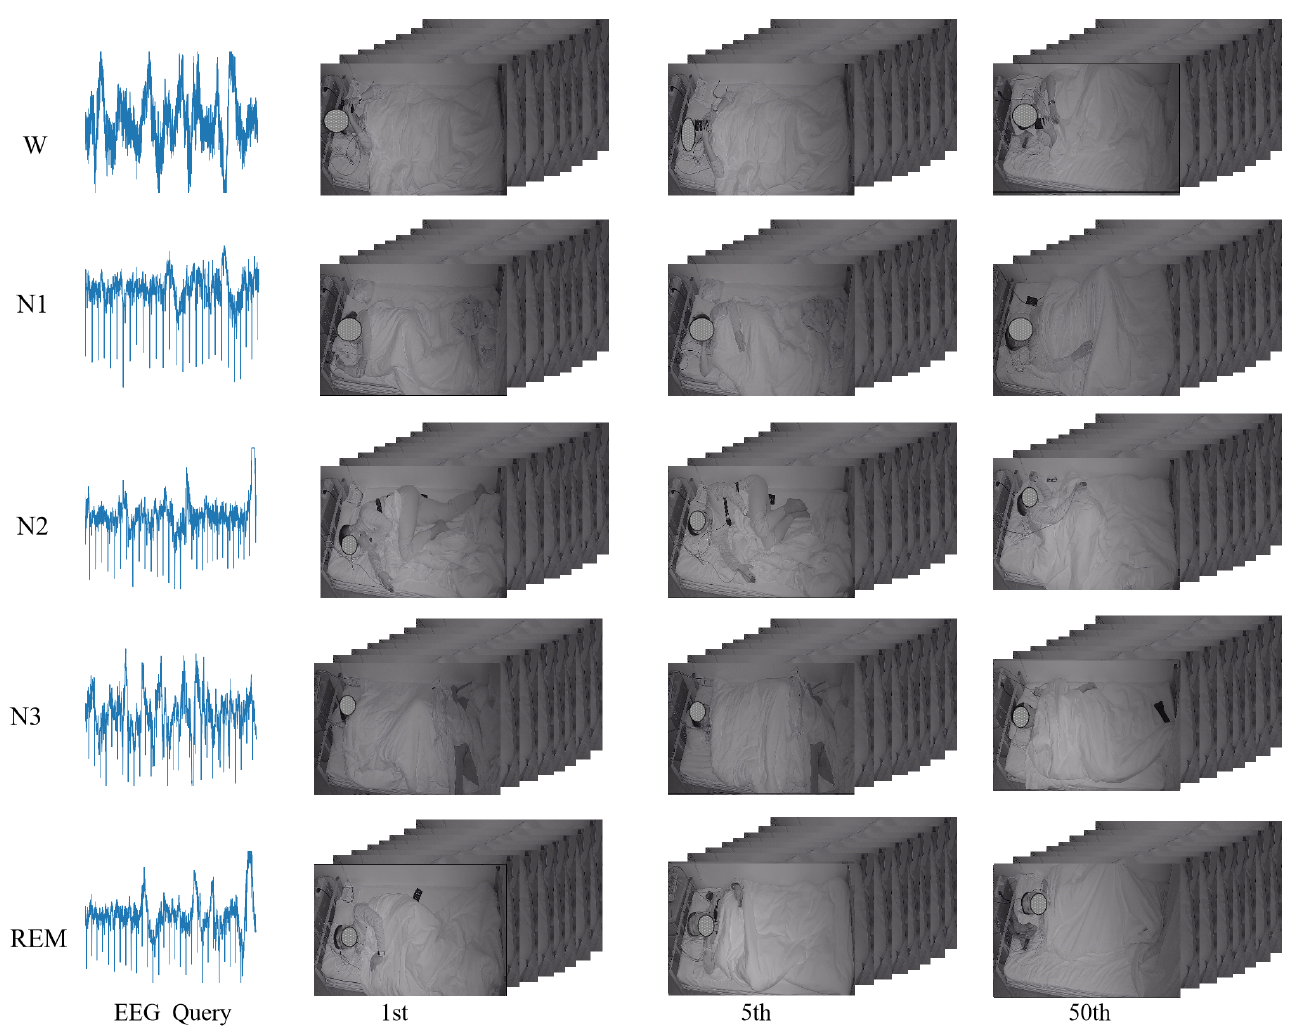
Figure 7. EEG → IR video results obtained when hash code length is 64 for S 3 VE dataset [60]. Regarding the EEG, we show the raw signal output by the PSG device, with some artifacts and noise, which we will analyze in detail in Section